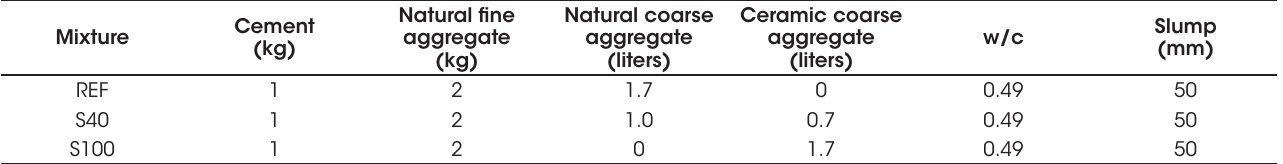
Mix proportions with and without waste